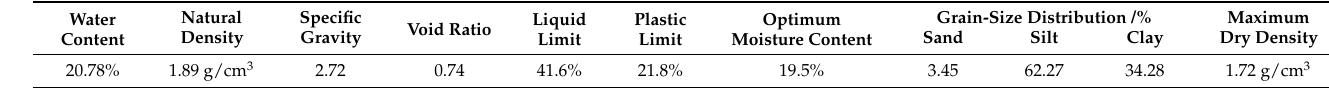
Table 1. Basic physical and mechanical properties of soil used in